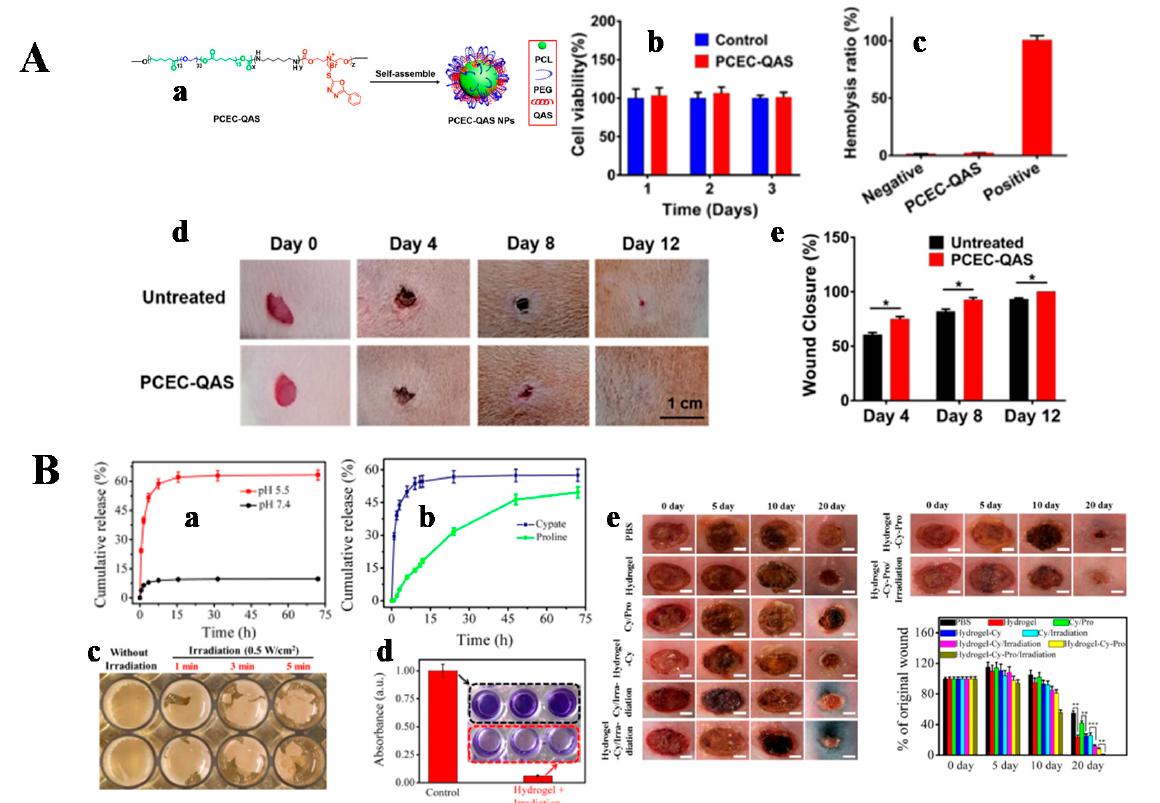
Figure 7. ( A ) The PCEC-QAS hydrogel. ( a ) Schematic diagram of the self-assembly of PCEC-QAS NPs; ( b ) relative viability of 3T3 cells inoculated on the PCEC-QAS hydrogel; ( c ) hemolysis ratio of the PCEC-QAS hydrogel. Negative and positive controls were normal saline solution and distilled water, respectively; ( d ) representative photographs of wounds at day 0, 4, 8, and 12; ( e ) wound closure rates. * p < 0.05. Reprinted with permission from Ref. [121]. Copyright 2020, American Chemical Society. ( B ) The IKFQFHFD peptide hydrogel. ( a ) Release curves of cypate loaded in the hydrogel-Cy system under different pH conditions; ( b ) release curves of cypate and proline loaded in the hydrogel-Cy-Pro system (under pH 5.5); ( c ) representative photographs of integrated MRSA biofilm incubated with cypate released from the hydrogel-Cy system at a scheduled time point of 4 h under a NIR laser (808 nm,0.5 W/cm 2 ) irradiation for different times; ( d ) crystal violet staining image and its corresponding absorbance for integrated MRSA biofilm incubated with the hydrogel-Cy system (under pH 5.5) for 4 h followed by NIR laser irradiation (808 nm, 0.5 W/cm 2 , 5 min) (the biofilm under NIR laser irradiation without incubation with the hydrogel-Cy system was used as the control); ( e ) in vivo wound healing. Reprinted with permission from Ref. [7]. Copyright 2019, American Chemical